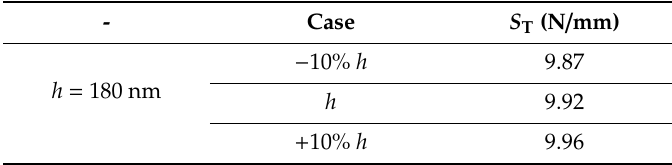
Table 2. E ff ect of the coating thickness ( h ) variation on the CVC sti ff ness ( S T ), assessed through FEM.